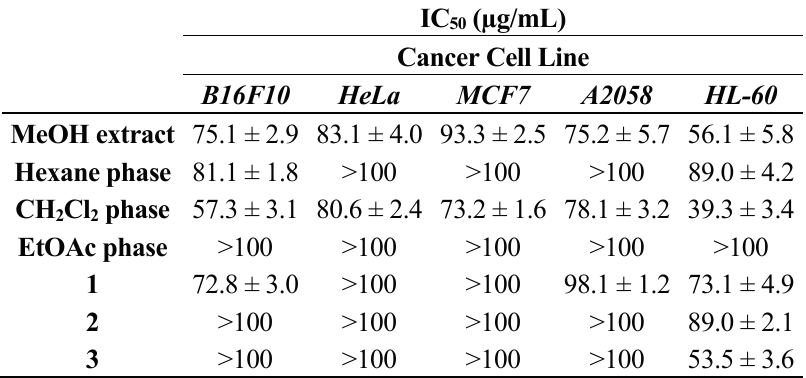
Table 1. IC 50 (µg/mL) values of neolignans 1 – 8 from N. megapotamica and positive control (cisplatin) against different tumor cell